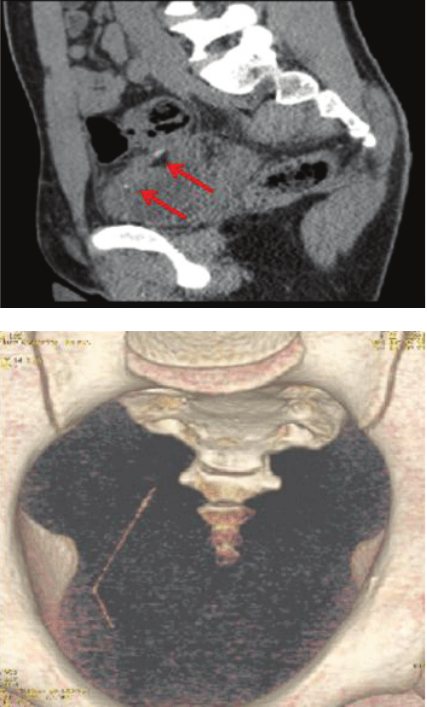
Figure 1: Presurgical cystography and cystoscopy. A small inflamed area is visible at cystoscopy.